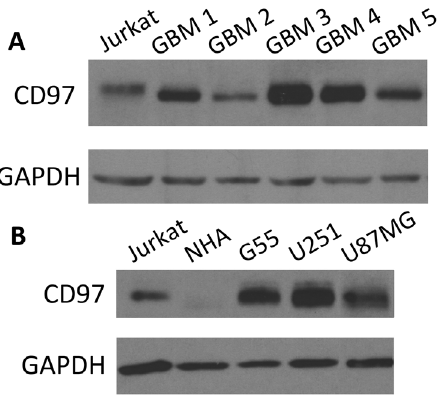
Figure 1. CD97 is expressed in primary GBM cultures and GBM cell lines. Five low passage primary GBM cultures and three GBM cell lines were analyzed. The five primary GBM cell lines, each isolated and cultured from a tumor resected at our institution, expressed moderate to high levels of CD97, suggesting that expression is heterogeneous among tumor specimens from different patients (A). Compared to normal human astrocytes (NHA), the GBM cell lines G55, U251, and U87MG expressed robust levels of CD97 (B). Jurkat cell lysates were used as a positive control since they are known to express CD97.